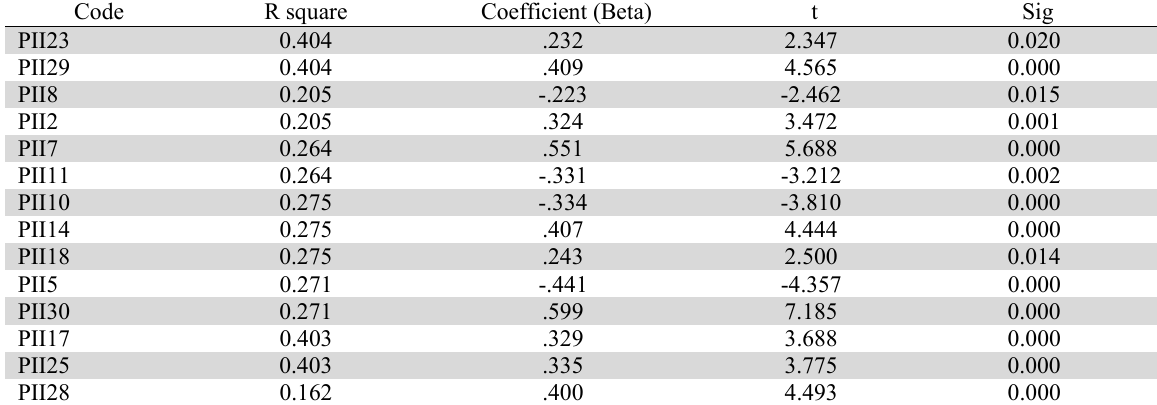
Summary result from regression model (employee’s performance) Code R square Coefficient (Beta) PII23